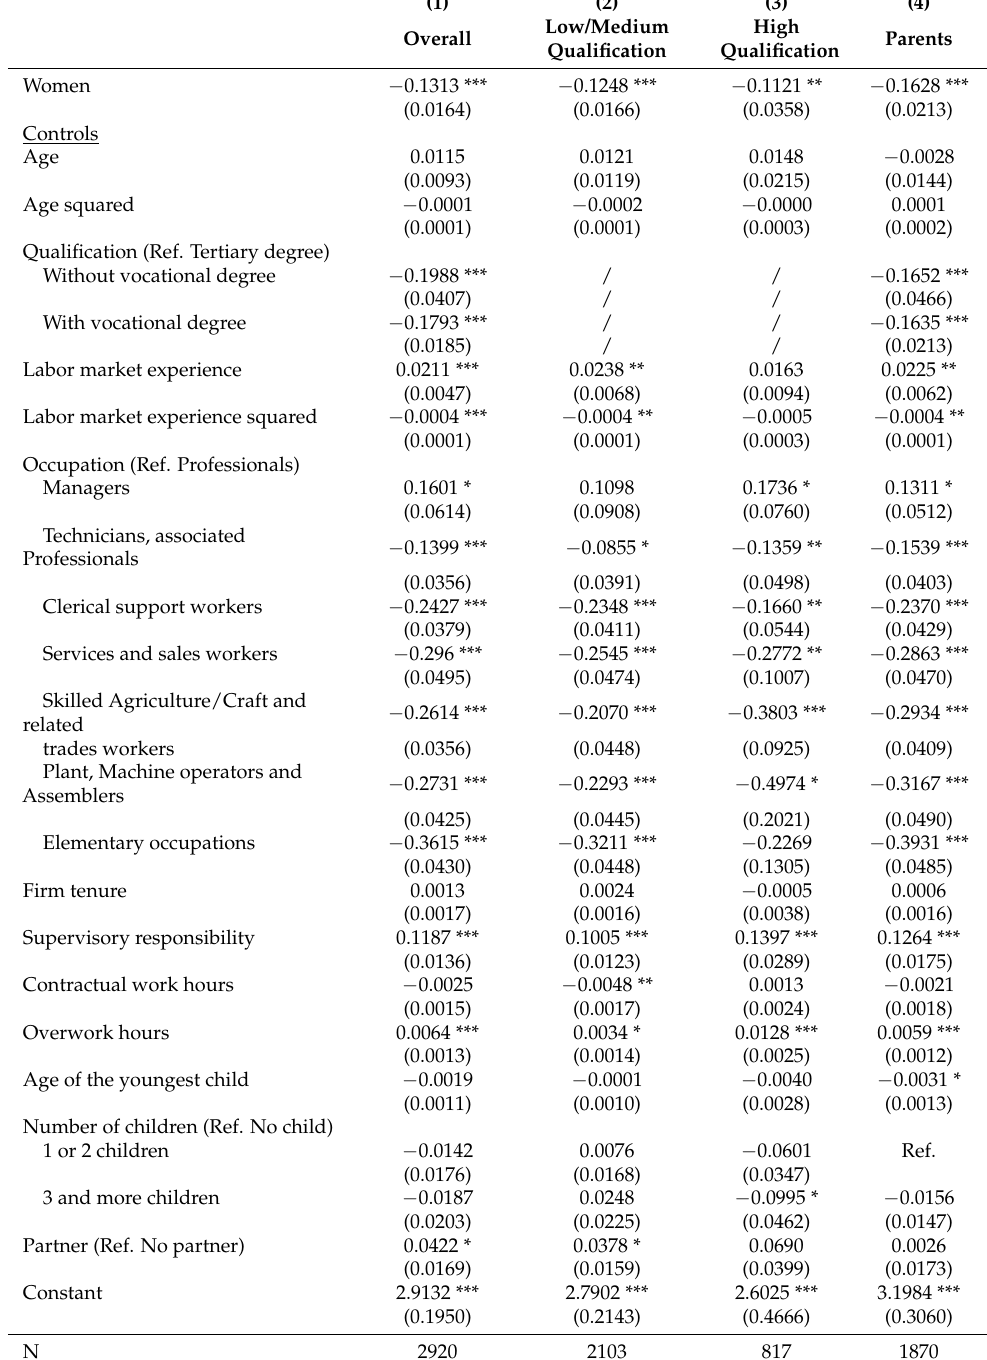
Table A8. Association of gender and log hourly wages within organizations without EQM including control